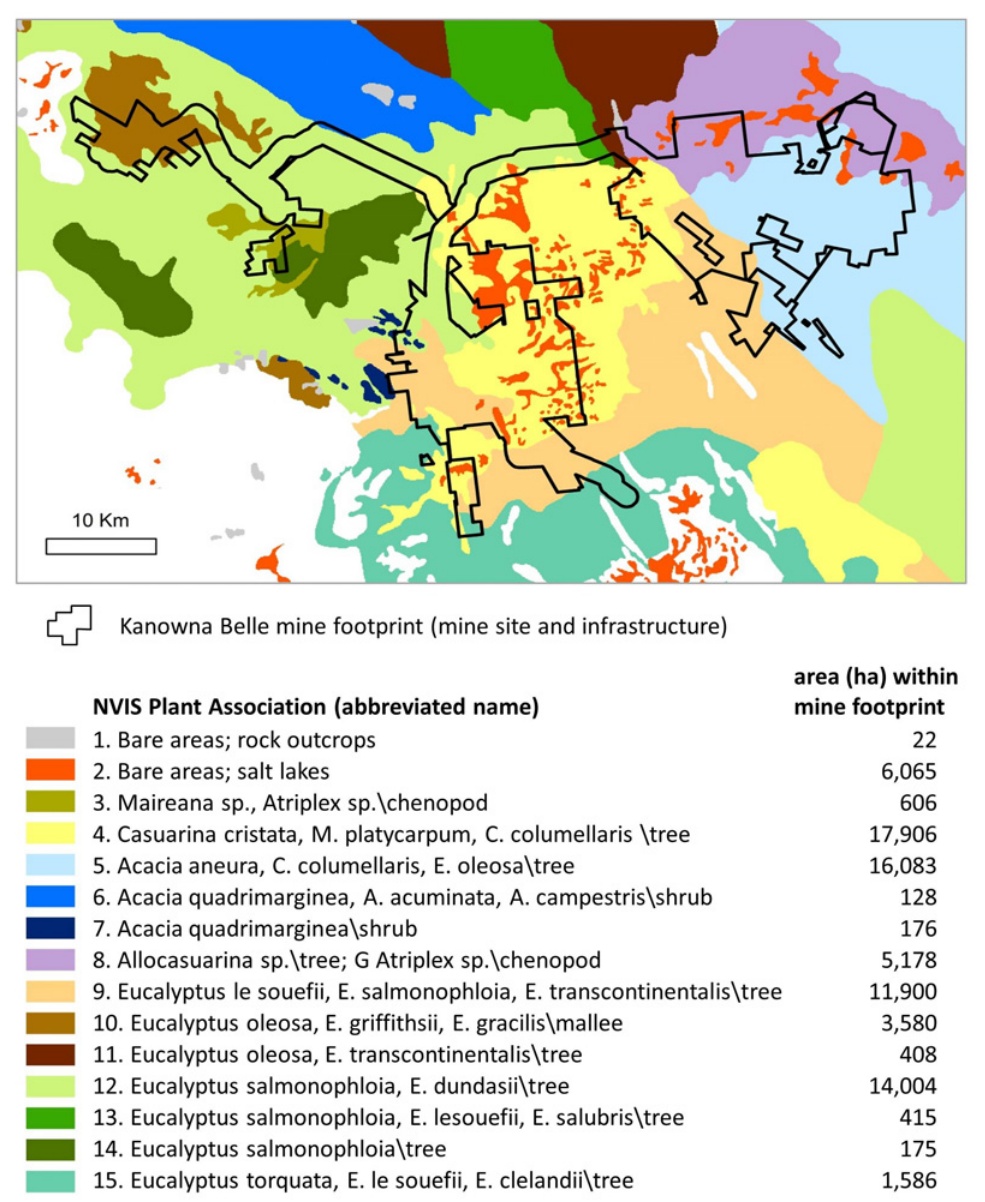
Figure 2. Habitat Types (NVIS plant associations) occurring within the mine footprint. We stratified plant associations by landforms to define and map 116 biodiversity elements across the study area, of which 71 occur within the mine